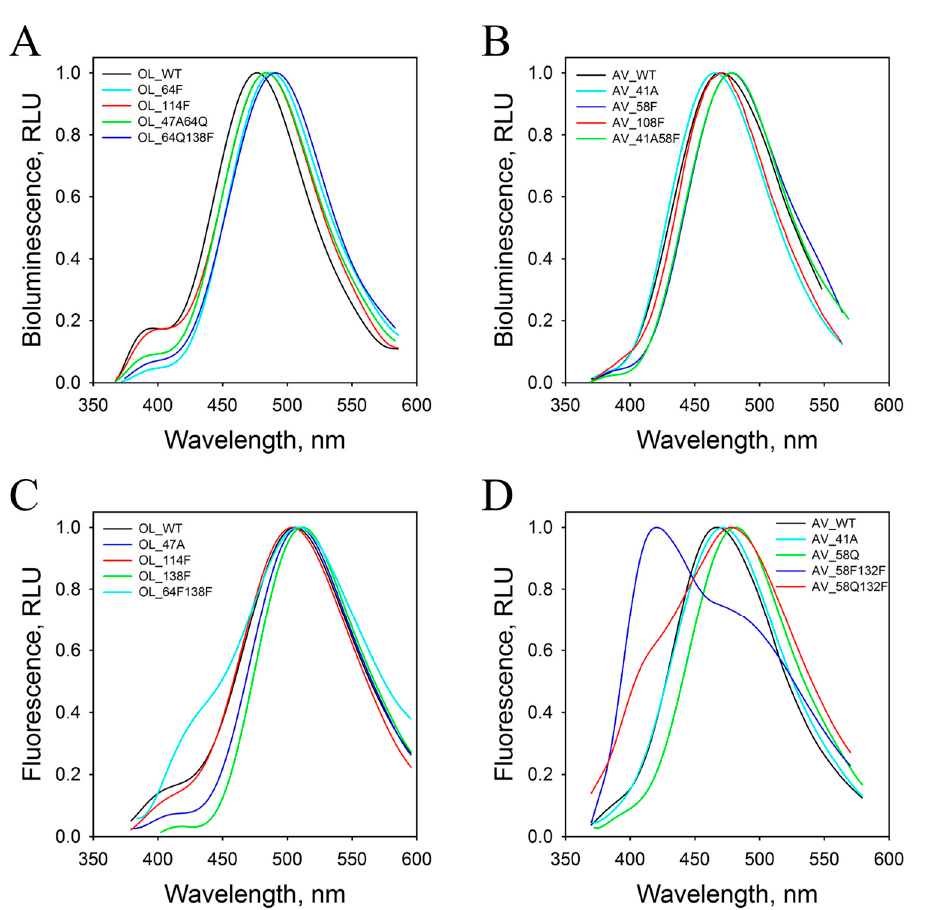
Figure 2. Normalized bioluminescence and fluorescence spectra of obelin ( A , C ), aequorin ( B , D ) and their mutants.